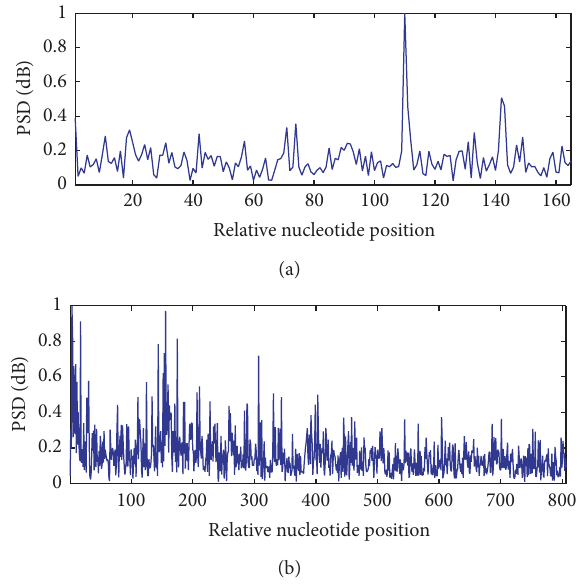
Figure 2: The power spectrum density (PSD) calculated by Voss- DFT of exon and intron from the gene F56F11.4. For the symmetry characteristics, only the first half of PSD is presented. (a) The PSD of an exon with the length of 330 basepair (bp), and the nucleotide position from 2528 to 2857, and the three-base periodicity (TBP) demonstrating peak at frequency 𝑘 = 𝑁/3 , where 𝑁 is the length of the exon. (b) The PSD of an intron with the length of 1612bp, and the nucleotide position from 5644 to 7255, but there is no remarkable peak in the whole